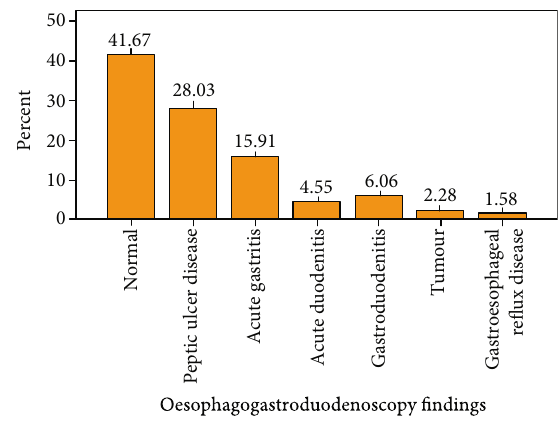
Figure 2: OGD fi ndings of the study group.